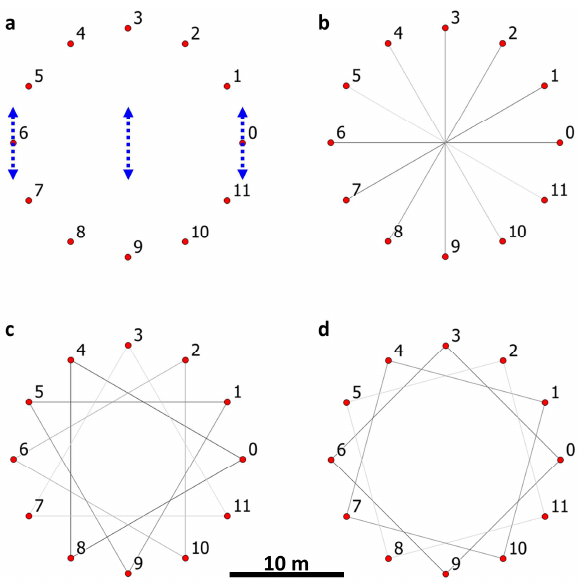
Figure 4: Examined configurations of terrestrial laser scan positions. (a) Single or all combined, (b) opposing, (c) triangular, (d) square. Grey scale lines indicate scan position combinations. Blue dotted arrows in (a) indicate ULS flight